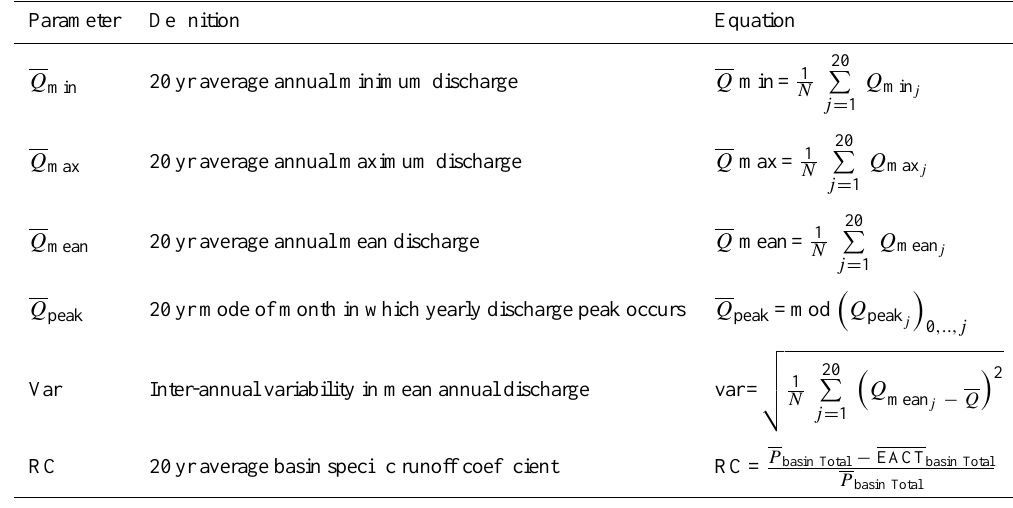
Table 2. Parameters included in analysis. Q mean of year j . j is the year number and ranges from 1 to 20. N =20, the total number of years. Q peak discharge peak occurred in year j . Q is the twenty year mean discharge. P sum is the twenty year average annual basin total precipitation sum and EACT sum is the twenty year average annual basin total modeled actual evaporation